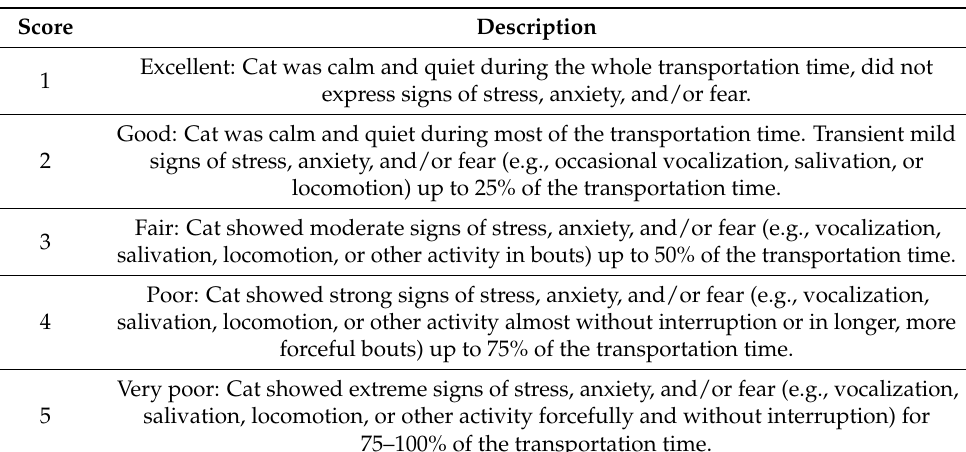
Table 1. Numerical rating scale for the owner’s assessment of the treatment effect based on the cat’s stress, anxiety, and/or fear during the transportation in a car. Modified from Lamminen et al. (2021)